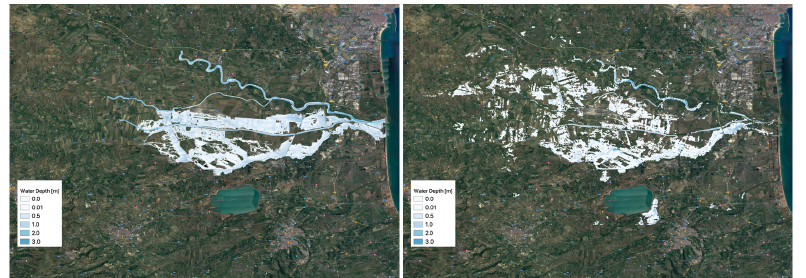
Figure 12. Water depths maps for the Catanian floodplain (Sicily) from TELEMAC-2D (left panel) and FwDET tool (right panel).